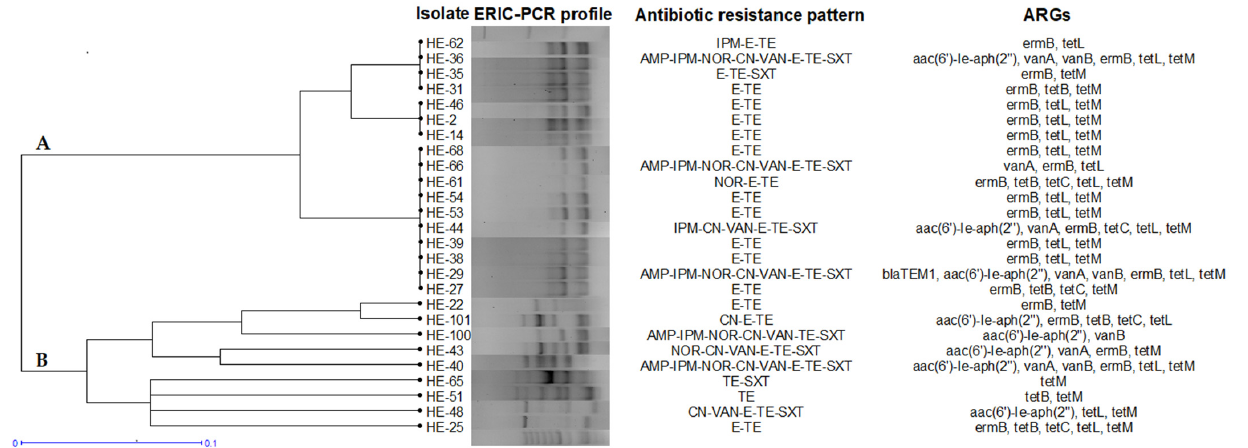
Figure 3. ERIC-PCR dendrogram and antibiotic resistance profiles of E. avium isolates. All isolates were from the hospital effluent.